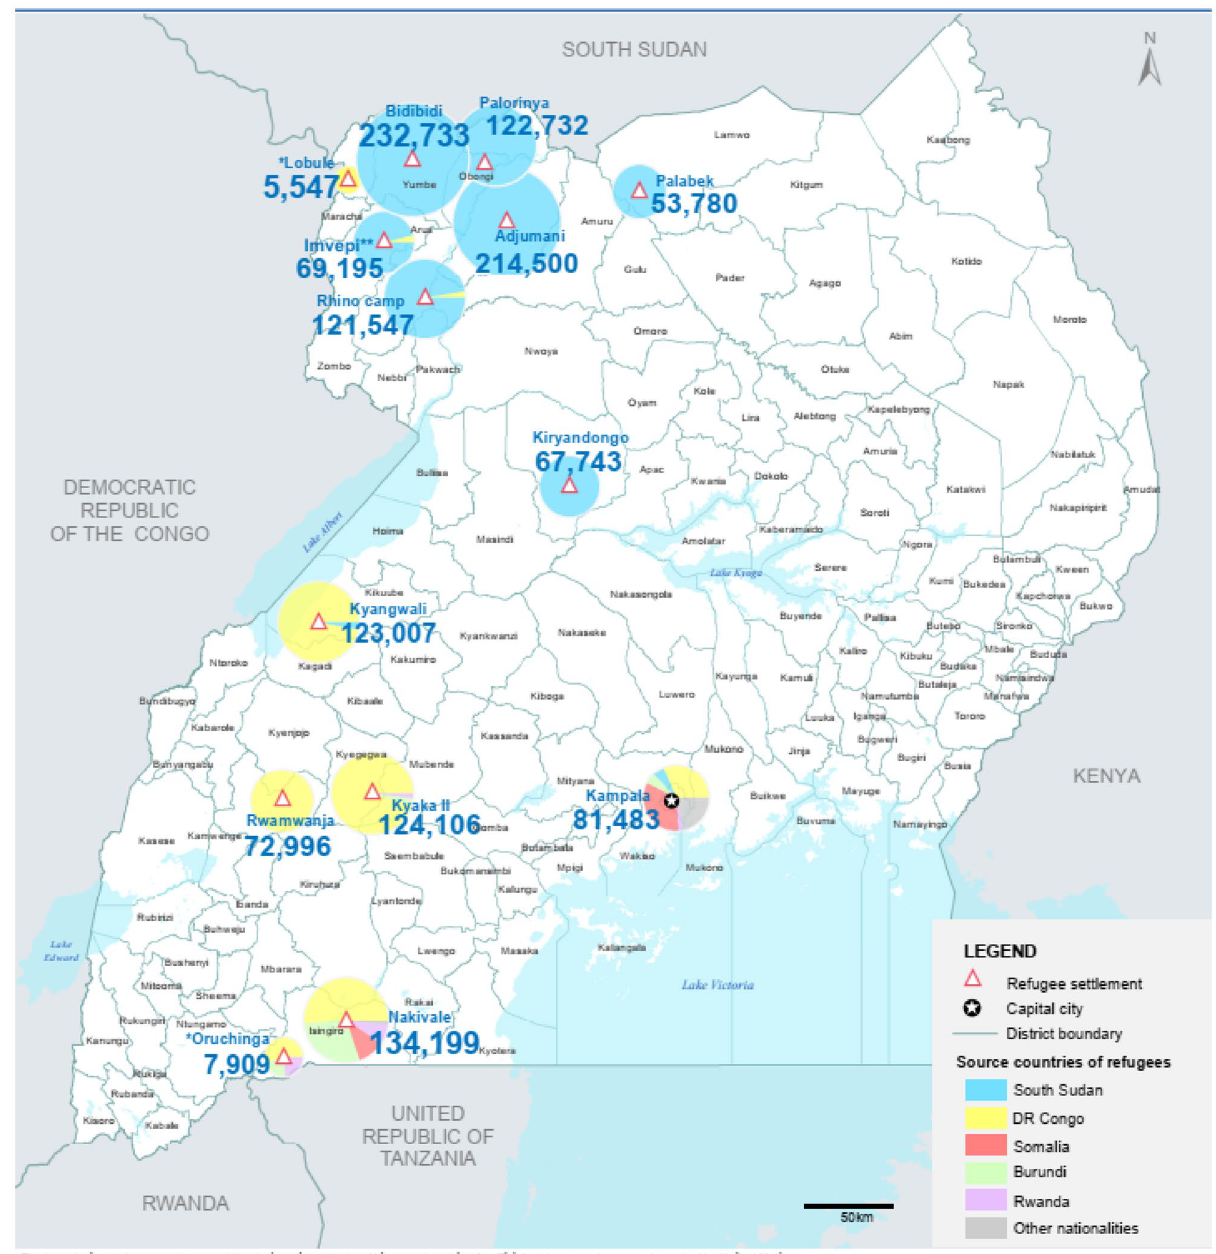
Fig. 3 Refugee population in Uganda